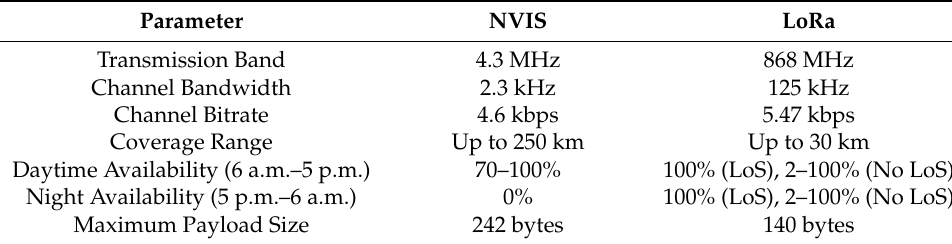
Table 1. Network parameters used to model the scenario.